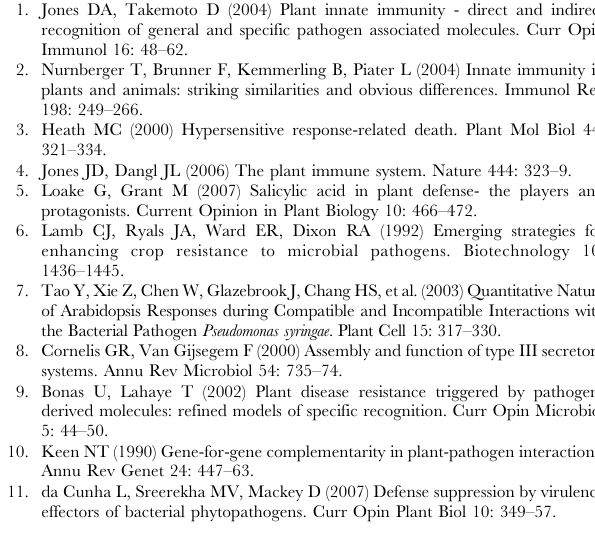
Figure S1 Cluster Analysis of Col-5 and Nd-1 specific gene lists. Cluster analysis with Adap_Cluster (Min_NR_Genes= 2, s= 0.95). A. 166 up-regulated genes assigned to the first cluster and 93 up-regulated genes assigned to the second cluster of the Col-5 specific gene list. B. 132 up-regulated genes assigned to the first cluster of the Nd-1 specific gene list. For each cluster, the mean expression profile is shown in red. Figure S2 Quantitative RT-PCR validation of selected differ- entially expressed genes at different time points. The microarray data (blue lines) were validated by Q-RT-PCR (pink lines). Samples were collected at the times indicated under each panel [0: 0H; 1: 6H; 2: 12H; 3: 24H; 4: 48H; 5: 72H; 6: 96H; 7: 120H (D1); 8: 168H (D3)] from: Nd-1 plants inoculated either with GMI1000 (R) or GMI1000 D PopP2 (S); Col-5 plants inoculated with GMI1000 (S) or GMI1000 D PopP2 (S); transgenic CH1.2 plants inoculated either with GMI1000 (R) or GMI1000 D PopP2 (S). The outcome of each interaction is shown below each panel (R, Resistance; S, Susceptible). The blue scale is for normalized Affymetrix data set and the pink one is for the relative quantity of RNA by Q-RT-PCR. A., B., C. and D. Protein phosphatase 2C, ABI2 (At5g57050), Protein Phosphatase 2C, ABI1 (At4g26080), 9- cis-epoxycarotenoid dioxygenase, putative (At3g14440), Rieske (2Fe-2S) domain-containing protein (At3g44880); 4 up-regulated genes in diseased Nd-1 and Col-5 plants. E. ATPase, plasma membrane-type, putative (At3g47950), a gene specifically up- regulated in diseased Nd-1. F. Peroxidase-related (At5g51890), a gene specifically down-regulated in resistant Nd-1 and CH1.2 plants. Found at: doi:10.1371/journal.pone.0002589.s009 (4.47 MB